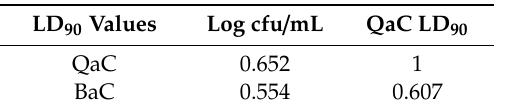
Table 4. Pearson’s correlation coe ffi cients for biofilm-forming ability parameters and LD 90 values for QaC and